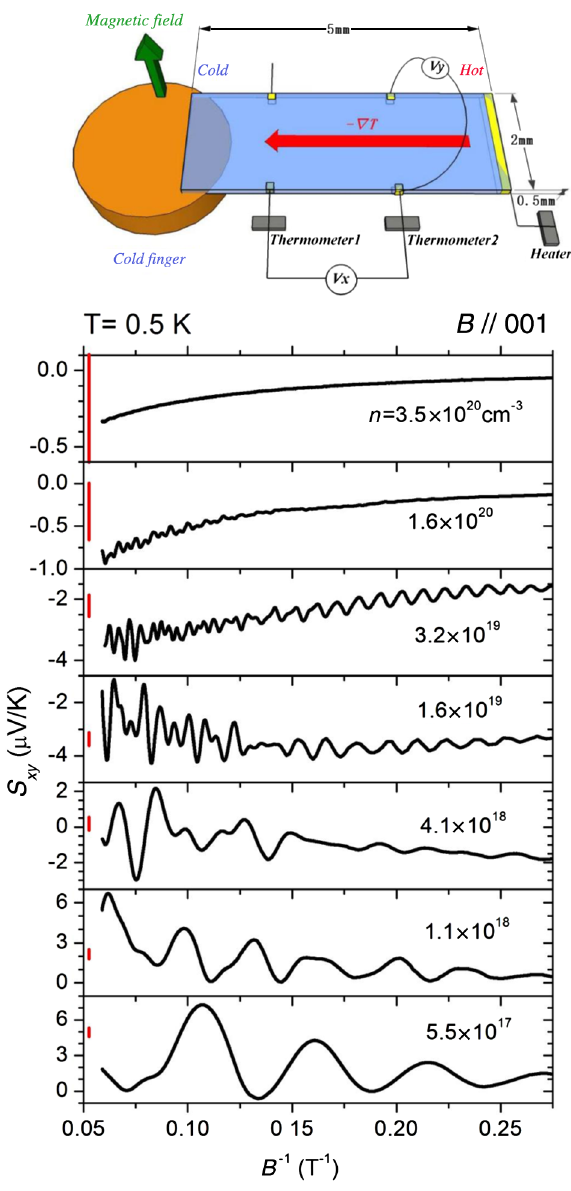
FIG. 1. Top: The experimental setup for measuring Nernst and Seebeck coefficients ofbulk chemically doped SrTiO 3 . Bottom: As the carrier density is reduced in SrTiO 3 , the Nernst signal shows oscillations with larger amplitude and longer periodicity. In each panel, the vertical red bar represents a constant scale of 0 : 7 (cid:1) V = K .